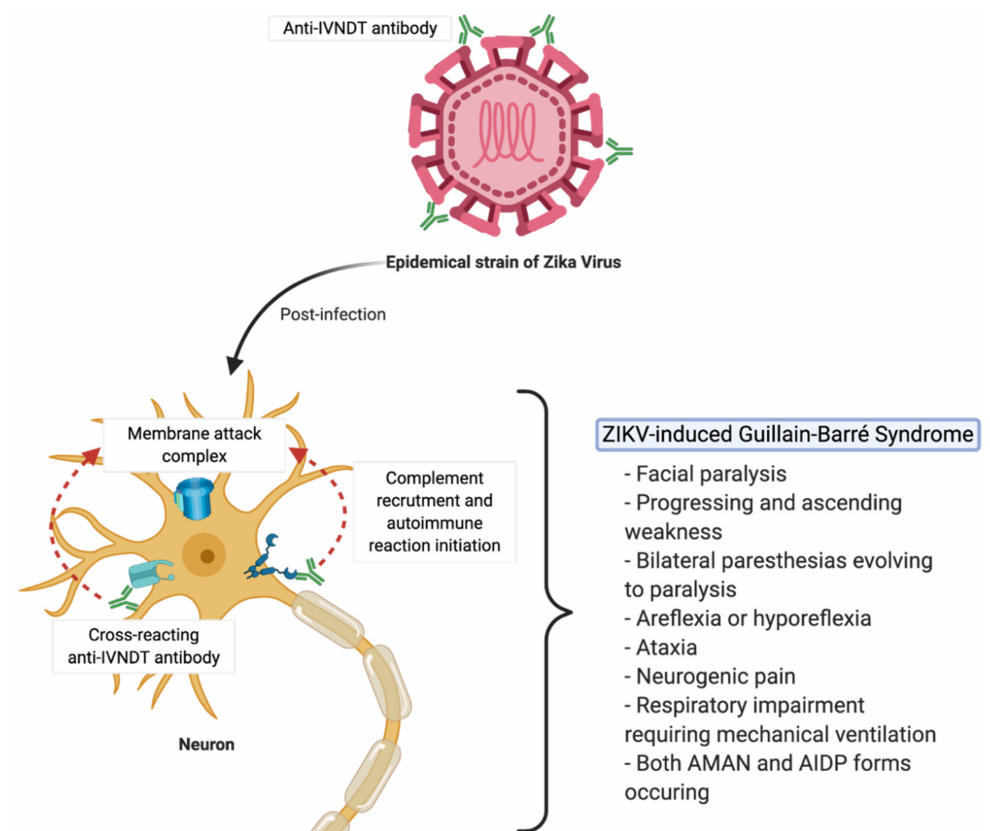
Figure 3. ZIKV-induced Guillain–Barr é Syndrome might be promoted by autoantibodies directed against calcium channel voltage-dependent L type α -1C subunit or Heat Shock 70 kDa protein